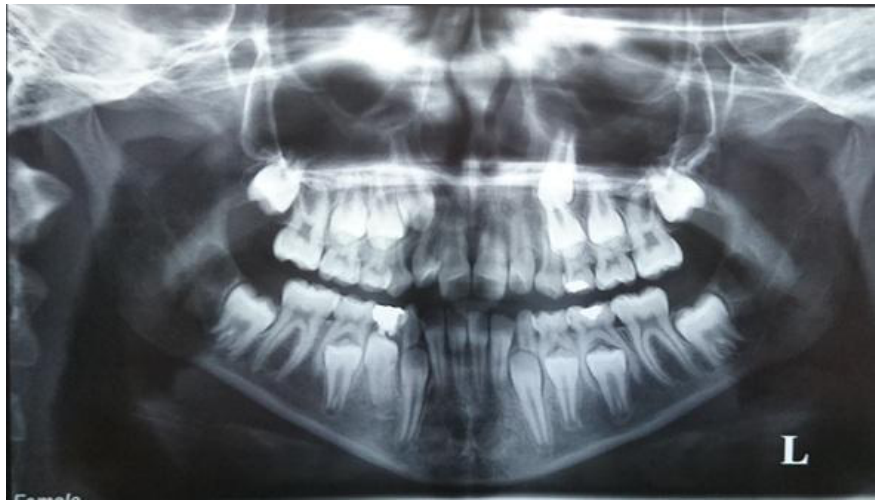
Figure 4. panoramic radiograph of the patient after three years follow-up at the age of 10.